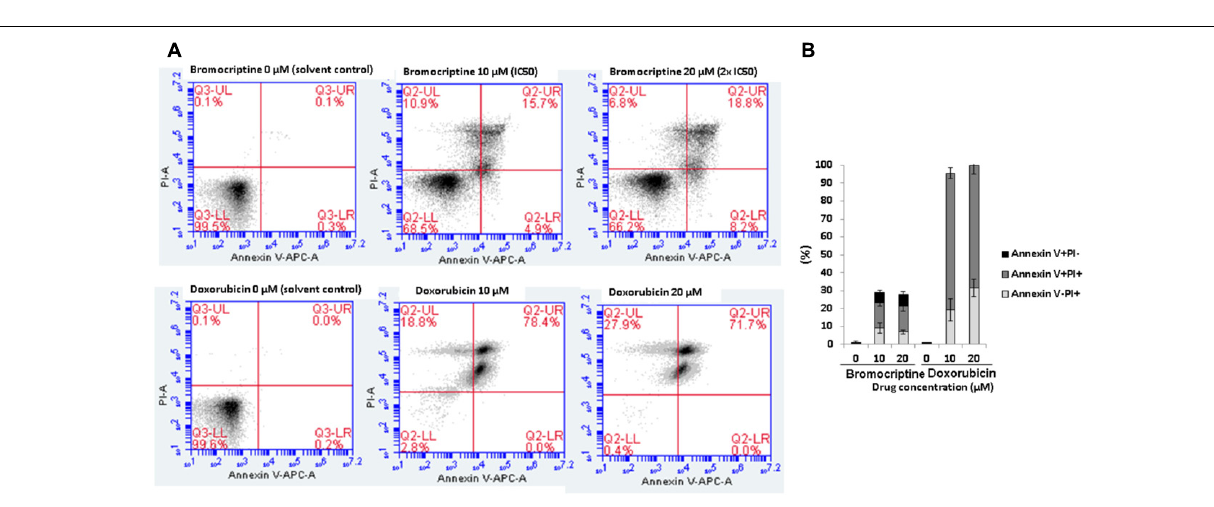
Frontiers in Pharmacology |